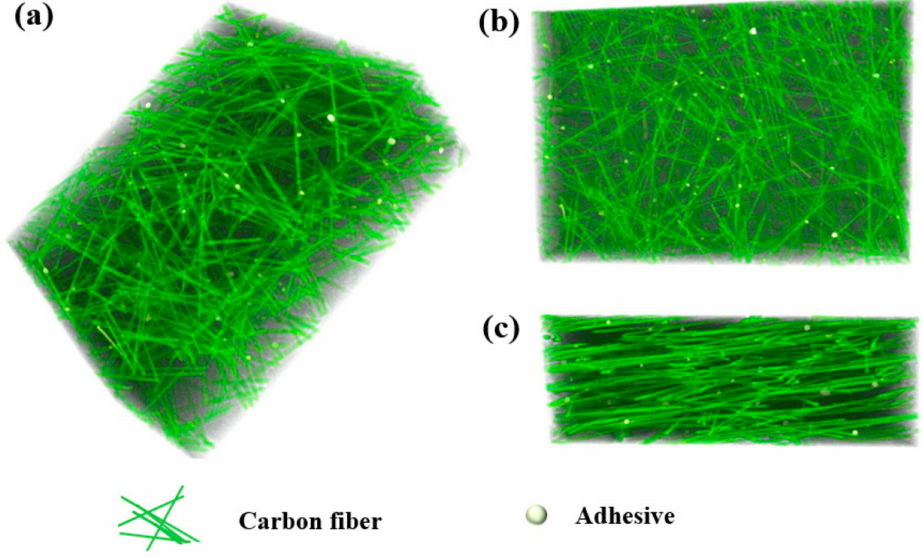
Figure 2. Micro-CT image of Co 3 O 4 /CP air cathode. ( a ) Front view, ( b ) Top view, ( c ) Side